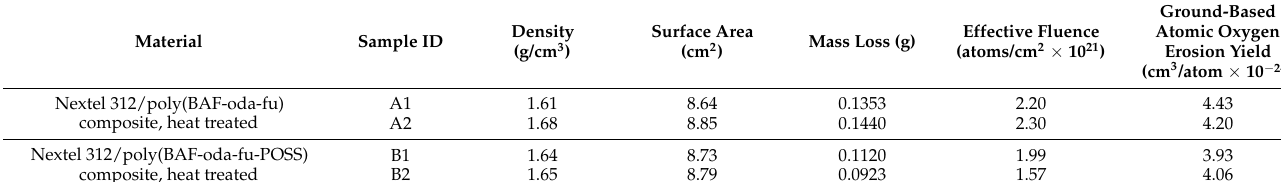
Table 2. Summary of Ground-Based Atomic-Oxygen Erosion Testing.